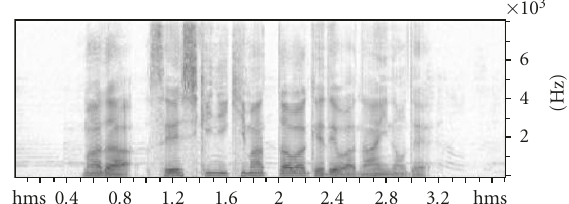
models [8] and stethoscope and silicon NAM microphones.